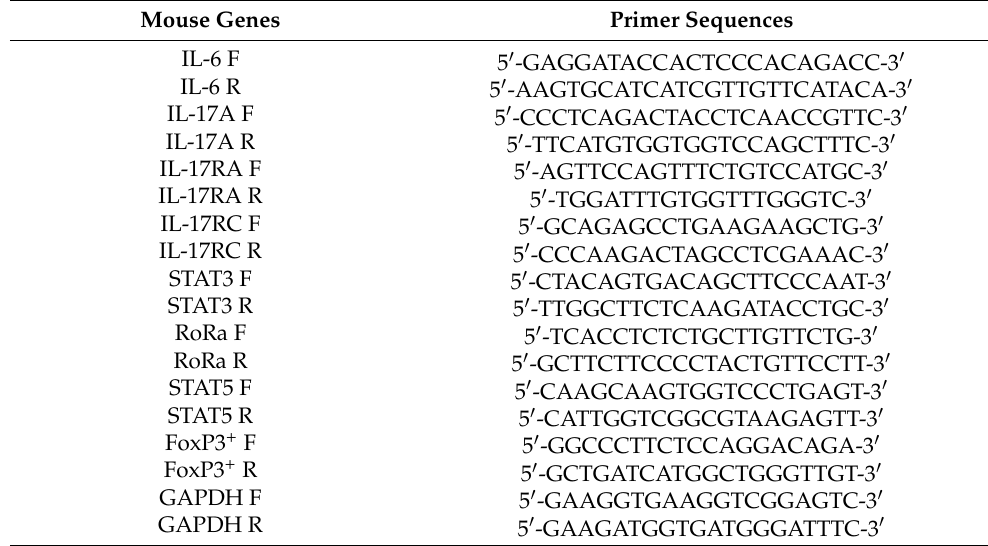
Table 2. Primer sequences of quantitative